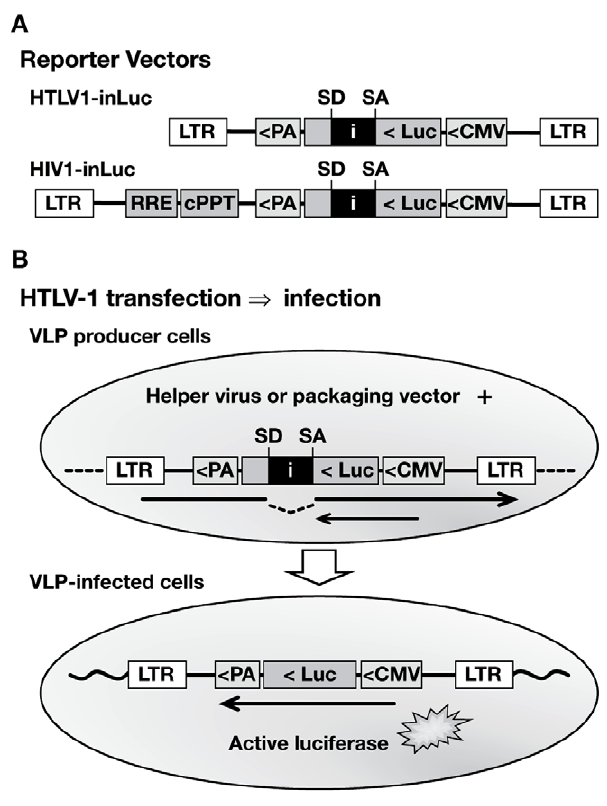
Figure 1. Specialized HTLV-1 and HIV-1 reporter vectors to measure single-cycle replication in coculture infection. ( A ) Replication-dependent HTLV-1 and HIV-1 transfer vectors contain an antisense-oriented expression cassette, which consists of a CMV promoter, firefly luciferase (luc) gene, and TK polyA signal (PA). The luc gene is interrupted by an intron ( i ), which is oriented in the sense direction, indicated by splice donor (SD) and splice acceptor (SA) sites. The HIV1-inLuc vector contains a Rev responsive element (RRE) and central polypurine tract (cPPT). Analogous vectors were constructed that contain a yellow fluorescent protein gene with intron (inYFP). ( B ) Translation of the reporter protein mRNA (small arrow) in transfected cells is blocked by the intron. The vector mRNA (large arrow) is spliced and packaged into VLPs; after infection and replication, a provirus is formed that lacks the intron and is capable of reporter gene expression.